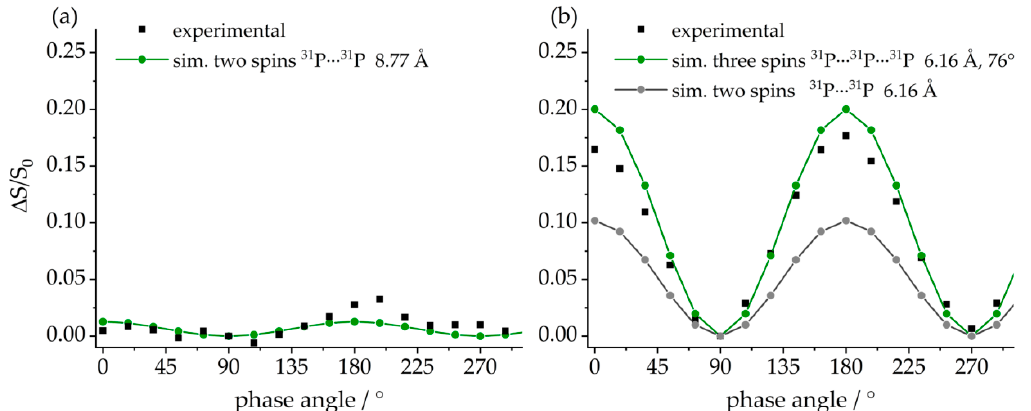
Figure 30. 31 P– 31 P CT-DRENAR curves (black squares) for ( a ) 8 and ( b ) 7 acquired for a dipolar recoupling time of 2.56 ms at 7.05 T, using a MAS frequency of 12.5 kHz with SWFTPPM [84] 1 H decoupling. The simulation in ( a ) is based on a two-spin system with a 31 P ... 31 P distance of 8.77 Å (green curve) based on the shortest internuclear distance in the single-crystal structure. In ( b ), two simulations are depicted: a hypothetical dimer (two-spin system, gray curve) and the tetramer (three-spin system, green curve). Each simulation considered a 31 P ... 31 P distance of 6.16 Å and, in the latter case, a 31 P ... 31 P ... 31 P angle of 76 ◦ based on the single-crystal structure. The agreement of the experimental data with the three-spin simulation gives clear evidence for the formation of the macrocycle.